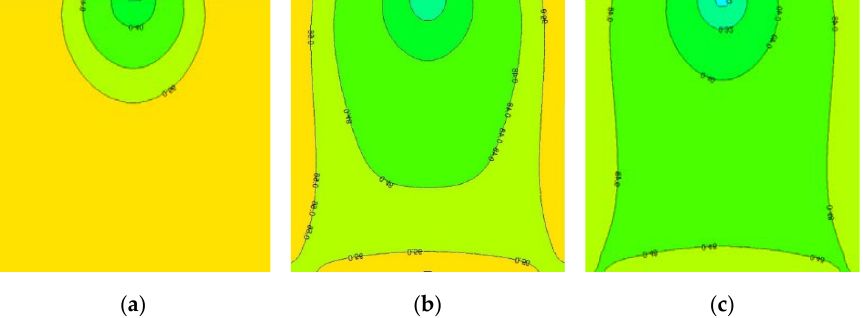
Figure 15. Remaining oil distribution of each layer after water flooding stage of Figure 4: ( a ) low- permeability layer, ( b ) medium-permeability layer, ( c ) high-permeability